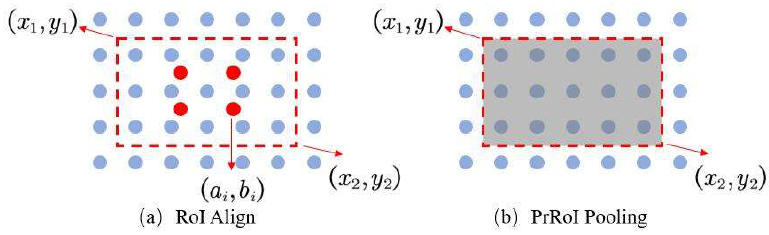
Figure 3. Comparison of pooling methods. ( a ) The RoI Align sampling a fixed number of points. ( b ) The PrRoI Pooling using a fully integrated averaging pool. Figure 2. Flow chart of the first stage of mask extraction.